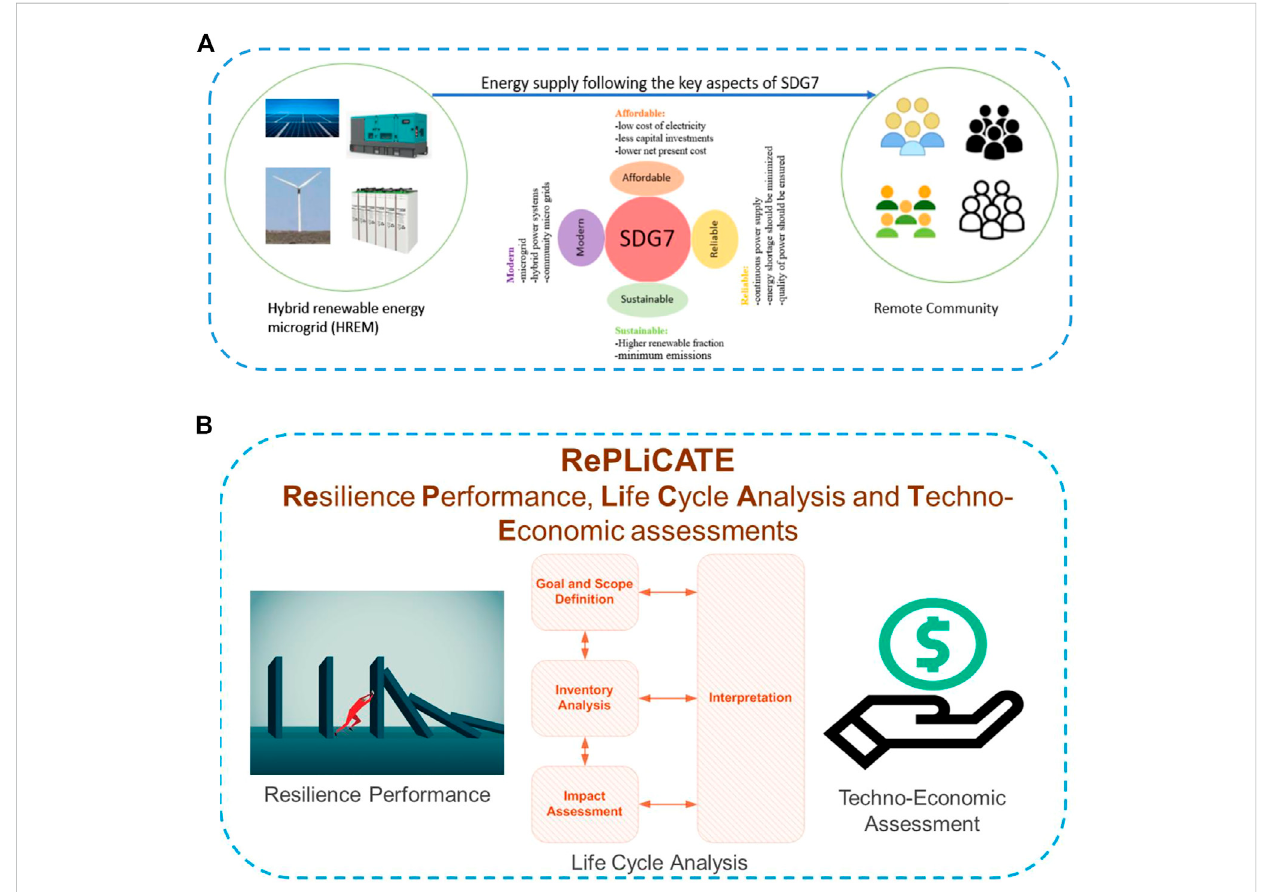
FIGURE 1 Approaches for Sustainable Planning and Lifecycle Thinking of Energy Infrastructure. (A) Energy Systems Design in line with SDG7. Adopted from authors own sources (Kumar et al., 2020; Nallapaneni and Chopra, 2021b); (B) RePLiCATE Approach. Adopted from authors own sources (Nallapaneni, 2021; Nallapaneni,